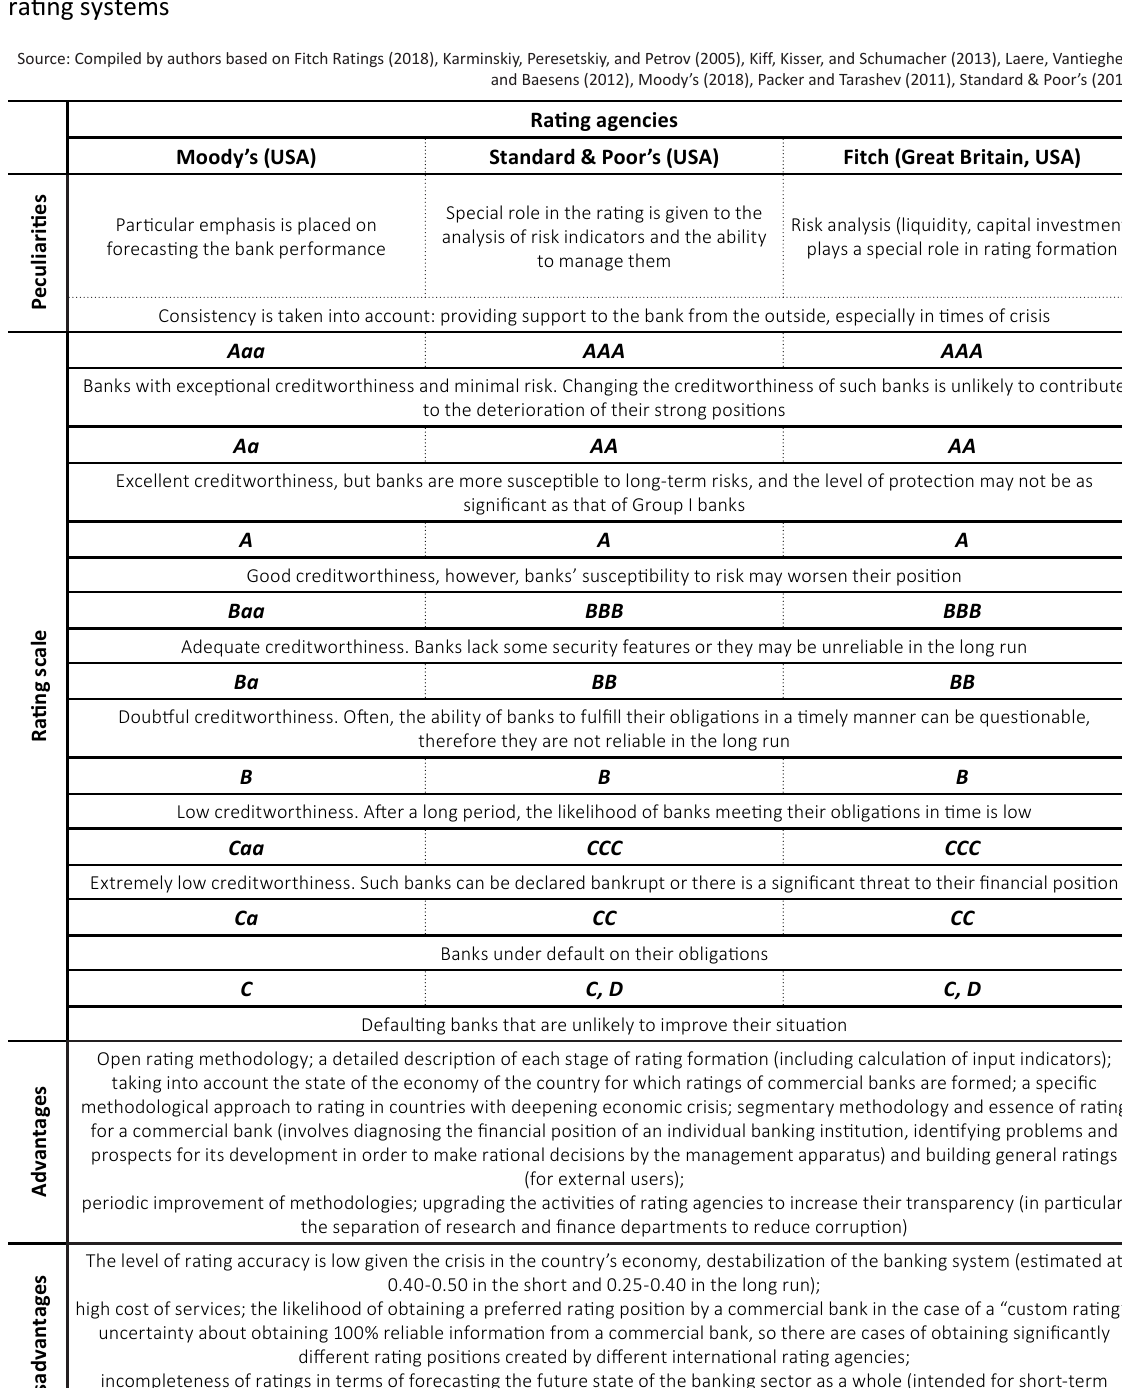
Table 2. Peculiarities, rating scale, advantages and disadvantages of international rating agencies’ rating